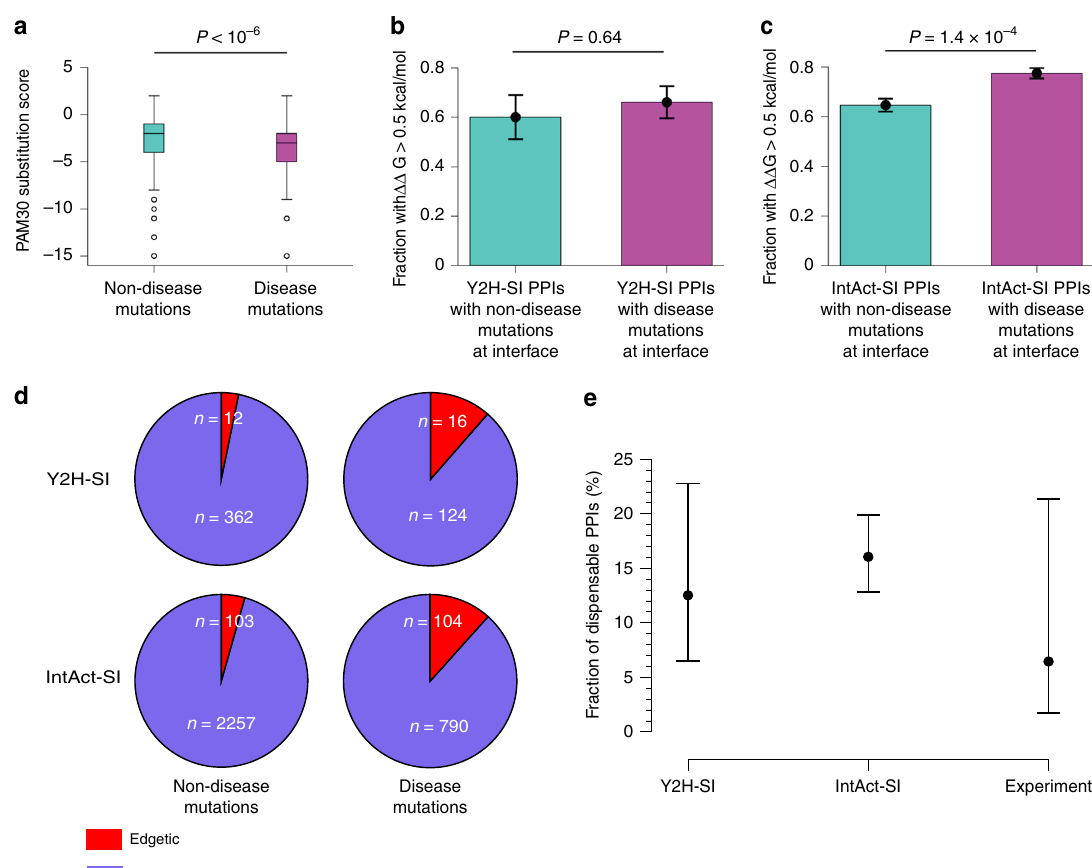
Fig. 4 Dispensable PPI content estimated from physics-based predictions. a Substitution score calculated using the PAM30 substitution matrix for all non- disease and disease-causing missense mutations in human. Center line represents the median value. Lower and upper bounds of the box represent the lower and upper quartile values, respectively. Whiskers represent the data range. Statistical signi fi cance was calculated using a two-sided bootstrap test with 1,000,000 resamplings. b , c Fraction of PPIs with mutations at the interface in the two human structural interactomes, b Y2H-SI and c IntAct-SI, that have a change in binding free energy ( ΔΔ G ) larger than 0.5 kcal mol − 1 upon mutation. ΔΔ G values were calculated from PPI structural models using BindProfX 49 . Error bars represent standard errors of the fraction. Statistical signi fi cance was calculated using a two-sided Fisher ’ s exact test. Source data are provided as a Supplementary Data fi le. d Fraction of edgetic mutations among common non-disease mutations (left) and among Mendelian disease- causing mutations (right), determined by physics-based prediction of mutation edgotypes in the two human structural interactomes, Y2H-SI and IntAct-SI. Red slices represent edgetic mutations, and purple slices represent non-edgetic mutations. Source data are provided as a Supplementary Data fi le. e Fraction of completely dispensable PPIs in the human interactome with 95% con fi dence interval, estimated from physics-based prediction of mutation edgotypes in the two human structural interactomes (Y2H-SI and IntAct-SI), and from mutation edgotypes obtained by experiments 8 . Bars represent